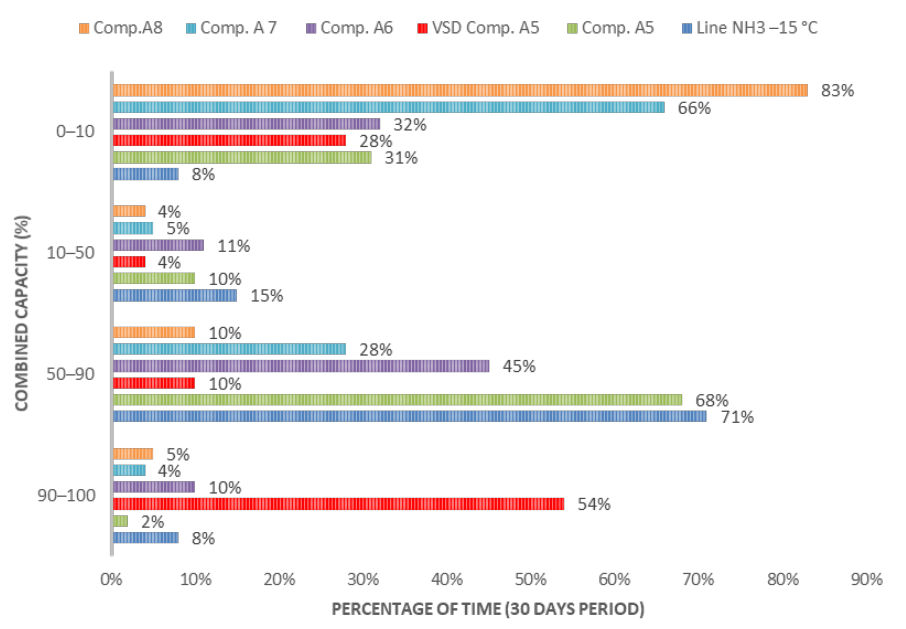
Figure 10. Capacity analysis for the −33 °C circuit.